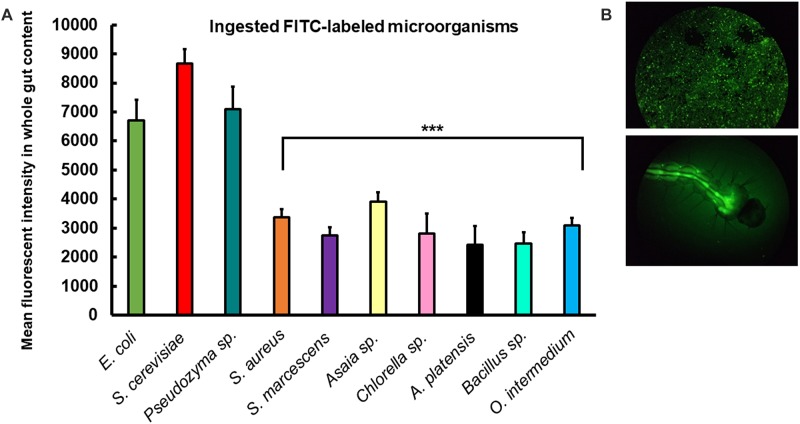
Ae. aegypti larvae consume different microorganisms offered in diets. (A) Mean fluorescent intensity in the intestine of larvae 2 h after placement of FITC-labeled microorganisms into rearing water. Columns present mean values with 95% confidence intervals for each diet (ANOVA 1; ∗p < 0.05; ∗∗∗p < 0.001). Figures are means ± SEM of 5 experiments with ten larvae each. (B) Epifluorescent images of microscope slide glass with FITC-labeled E. coli (D31) and individual larva 2 h after placing FITC-labeled E.coli (D31) into the rearing water.